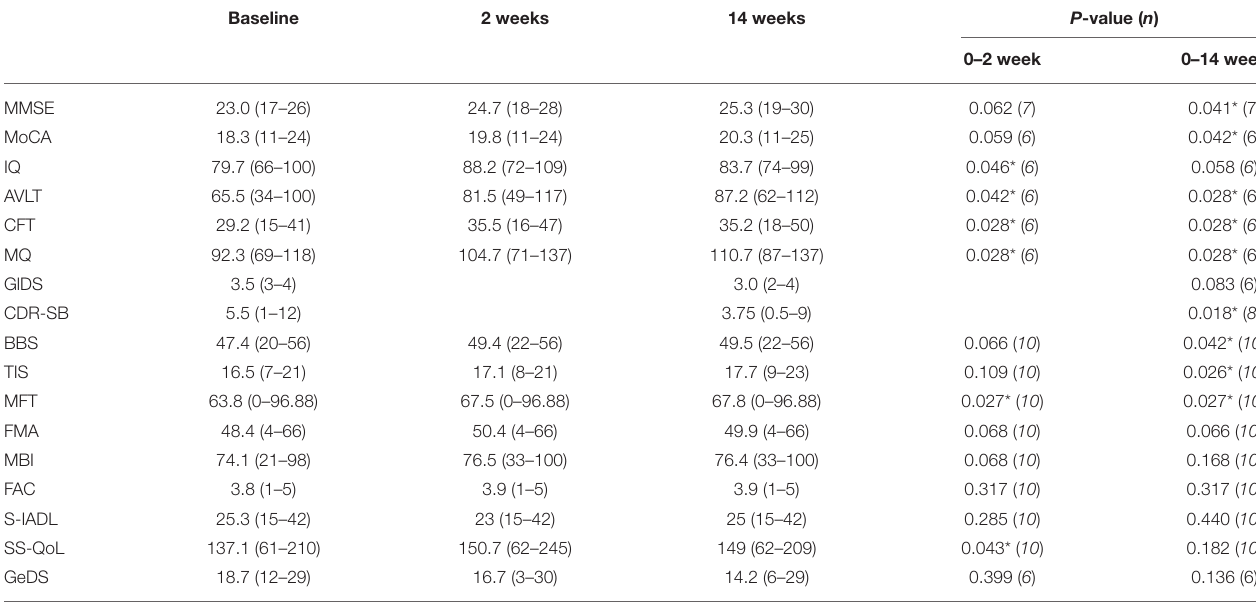
TABLE 2 | Changes in scores of functional evaluation after rTMS. Baseline 2 weeks 14 weeks